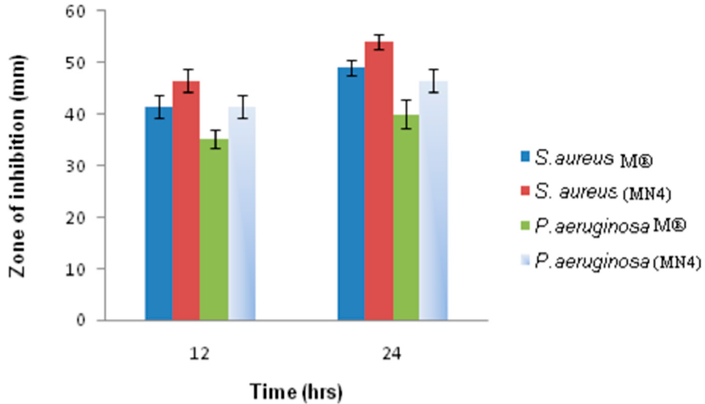
Figure 3. Anti-bacterial activity of optimized moxifloxacin-loaded nanosuspension (MN4) vs. marketed eye drops (M ® ) [68]. eye drops (M ® )